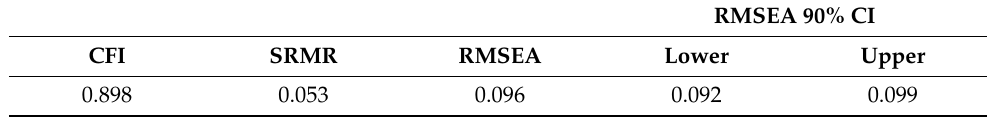
Table 3. Fit Measures without Modification Indices.